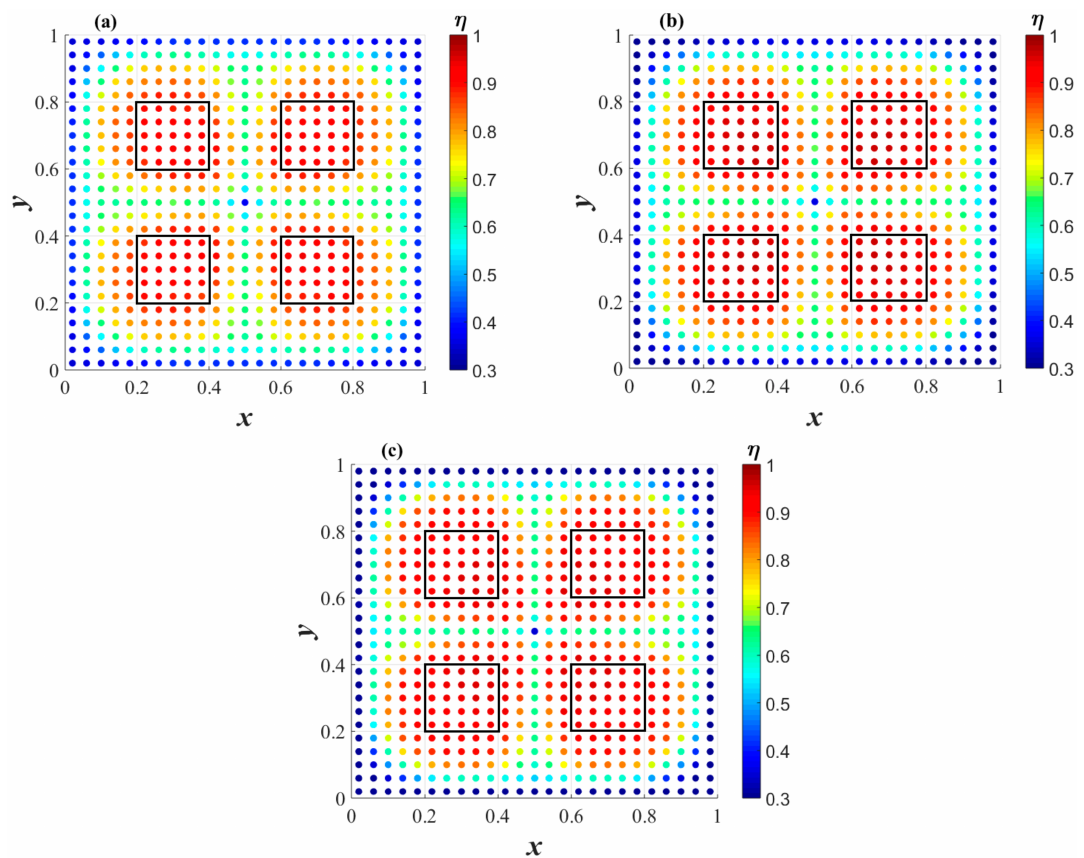
Figure 3. Energy dissipation ratios of five NESs at different positions under different excitation amplitudes: ( a ) f = 1; ( b ) f = 3; and ( c ) f =